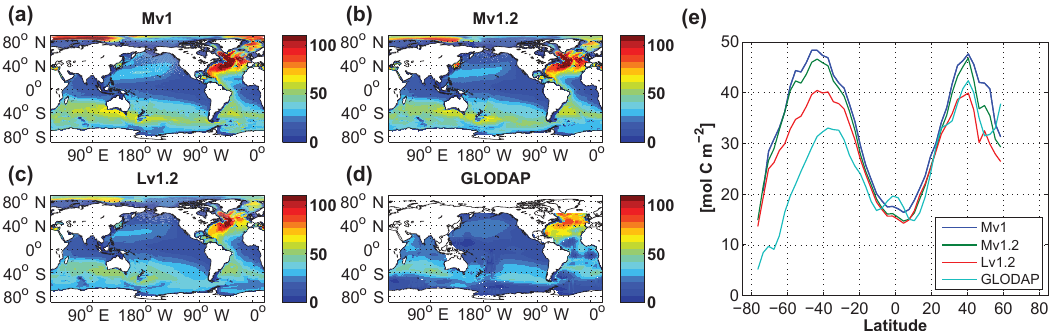
Figure 22. Vertically integrated anthropogenic carbon (molm − 2 ) for the year 1994 for model configurations (a) Mv1, (b) Mv1.2, and (c) Lv1.2, and (d) corresponding DIC ant from the observation-based GLODAP climatology (Sabine et al., 2004). Panel (e) displays the zonal mean of each field presented in panels (a–d) .